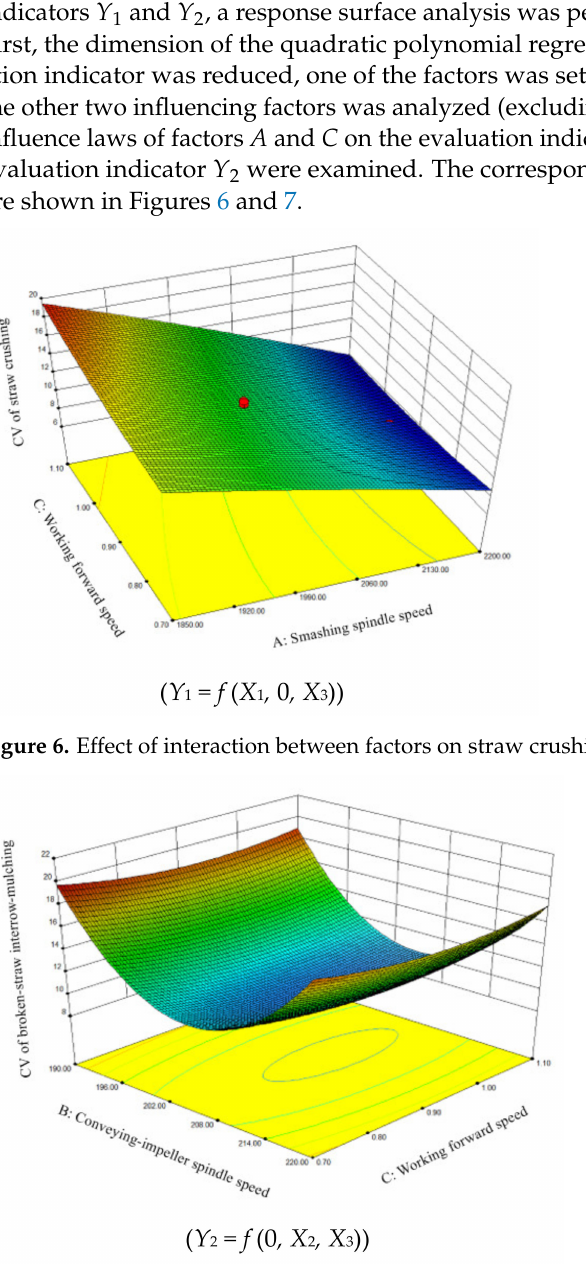
Figure 7. Effect of interaction between factors on inter-row straw mulching